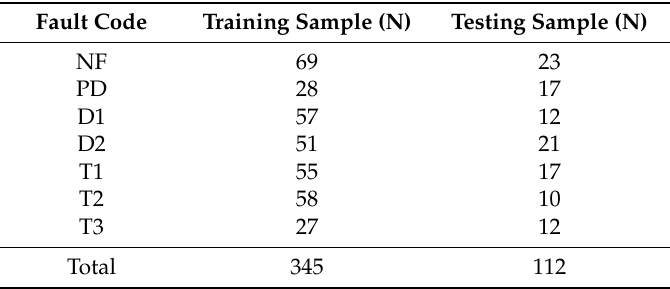
Table 2. Training sample distribution table.